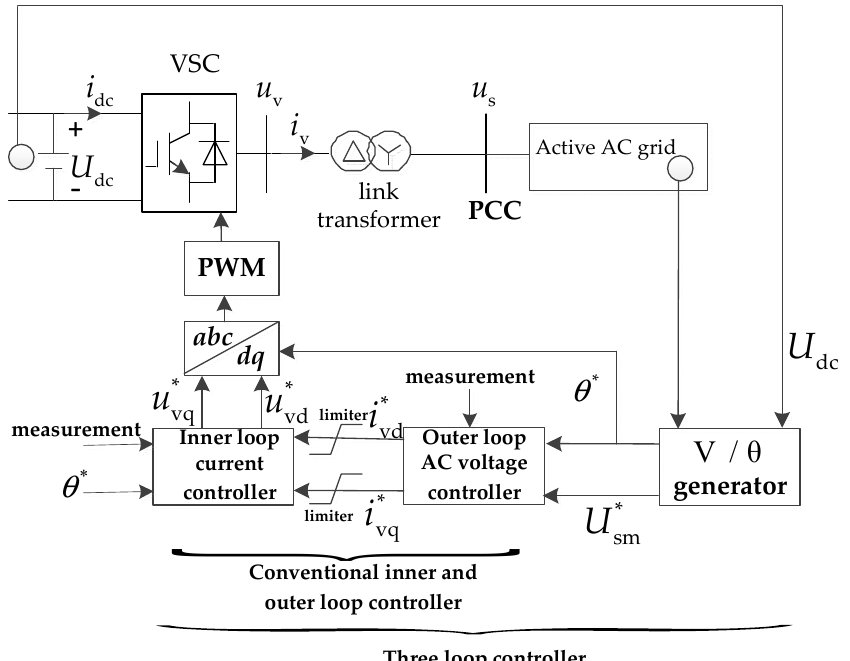
Figure 3. Three-loop controller diagram of the PV type grid-forming nonsynchronous-machine